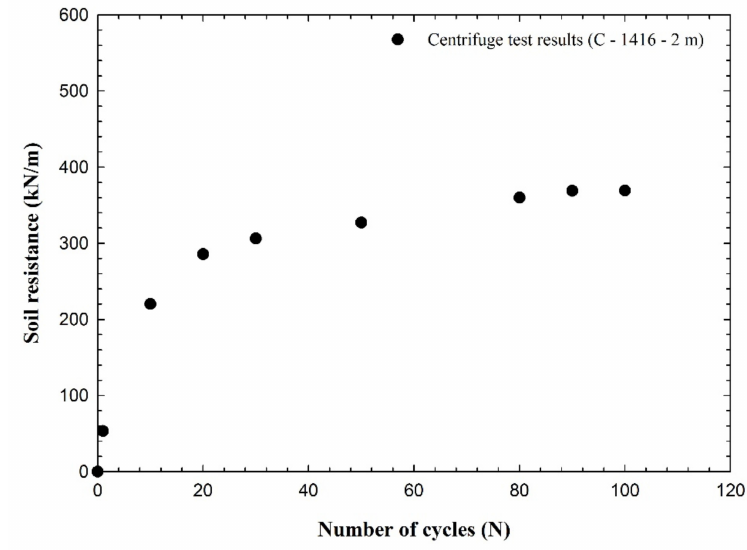
Figure 10. Ultimate soil resistance according to the number of cycles.